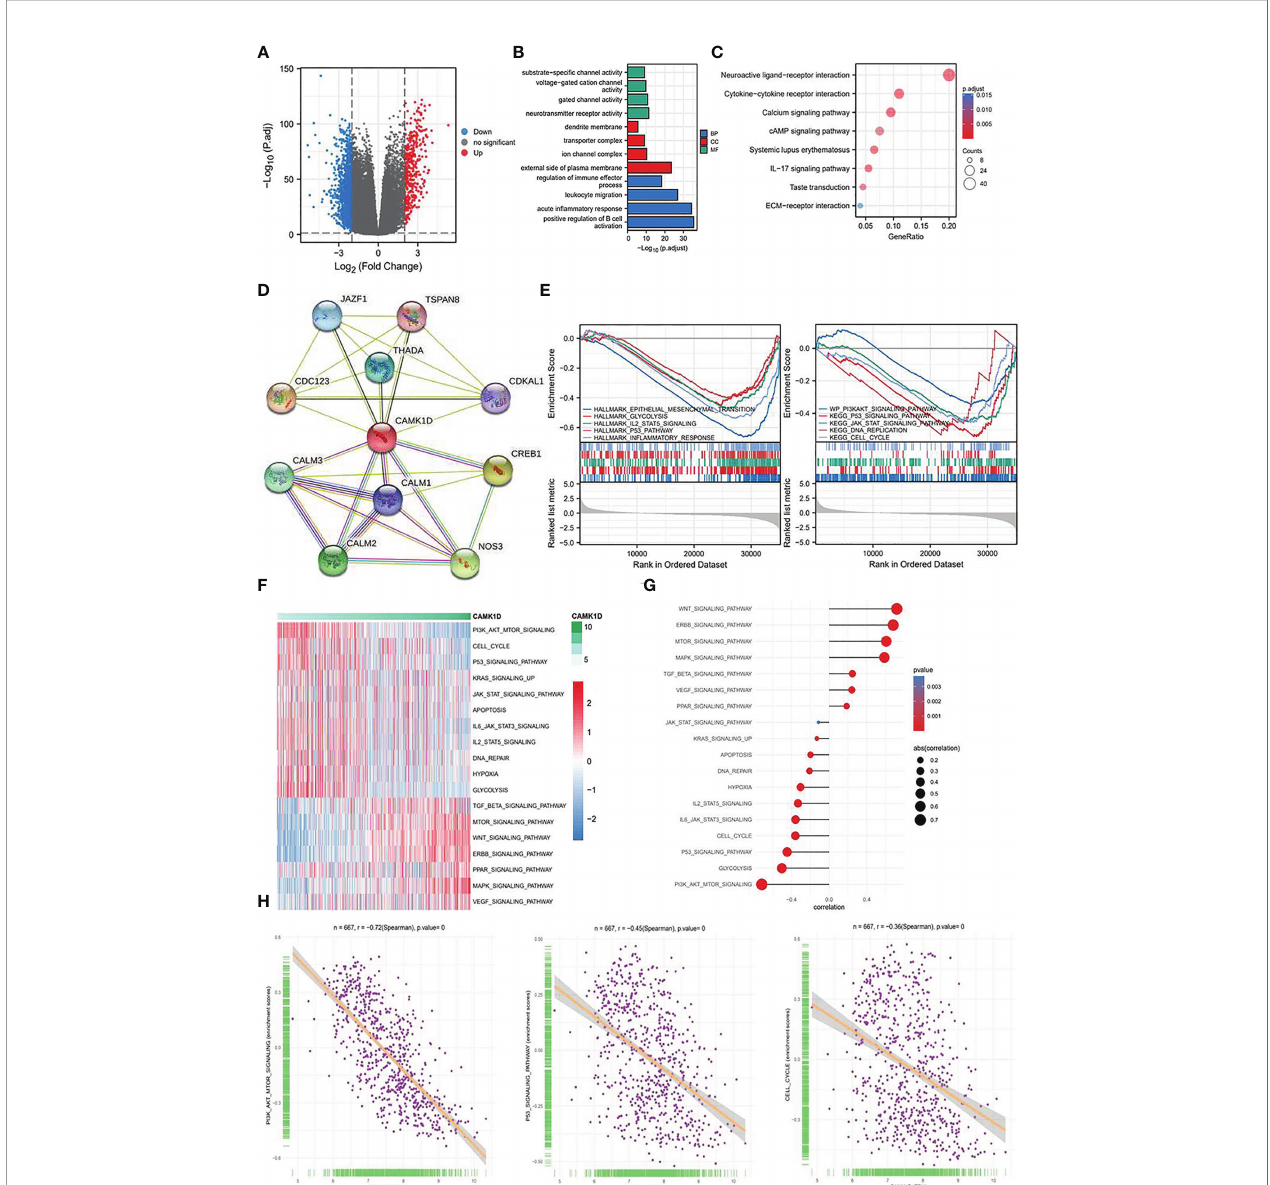
FIGURE 6 | Determination of the biological mechanism and processes affected by CAMK1D. (A) The Volcano plot showed the DEGs in low- and high-CAMK1D groups. (B) Analysis of GO enrichment for the DEGs. (C) Analysis of KEGG pathway enrichment for the DEGs. (D) The PPI network of CAMK1D constructed by the STRING database. (E) GSEA between the low- and high-risk group (F) The heatmap showed the GSVA scores of 18 pathways in low- and high-risk populations. (G) The association graph between GSVA and risk scores of 18 pathways. (H) The correlation between the PI3K/AKT/mTOR signaling, P53 signaling, cell cycle, and the expression of